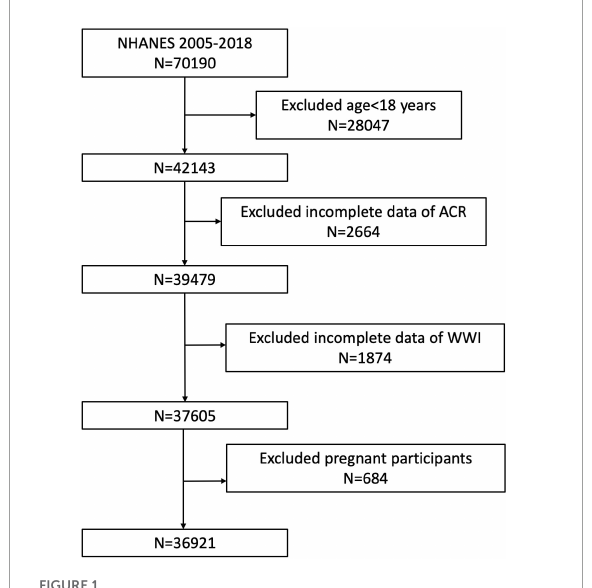
FIGURE1 Flowchart of the sample selection from NHANES 2005–2018. A total of 70,190 participants were enrolled at first, and after the exclusion of participants aged < 18 years ( n = 28,047), missing the data about ACR ( n = 2,664), WWI ( n = 1,874), and pregnant ( n = 684), 36,921 eligible participants were included in our final